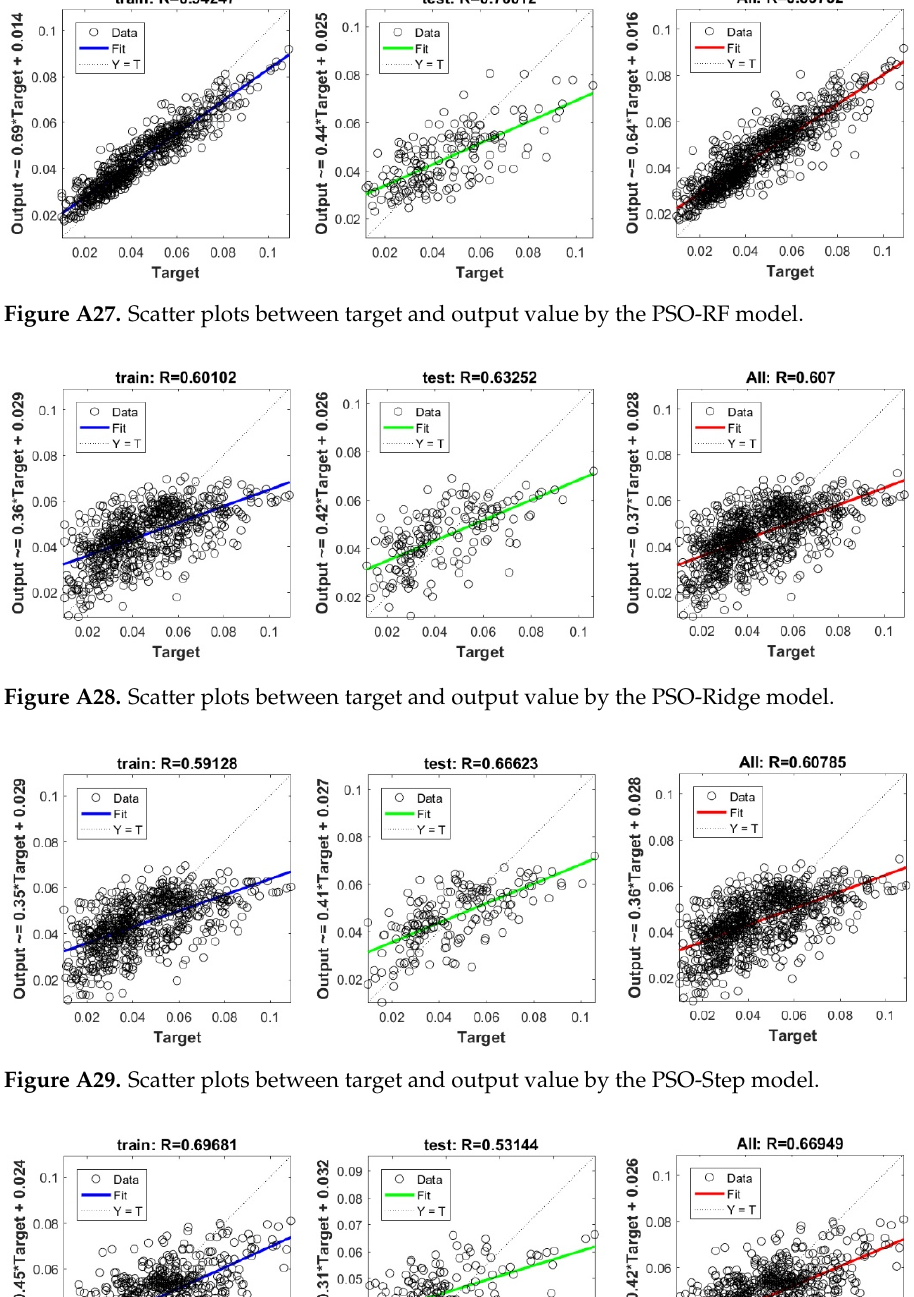
Figure A26. Scatter plots between target and output value by the PSO-PLS model.